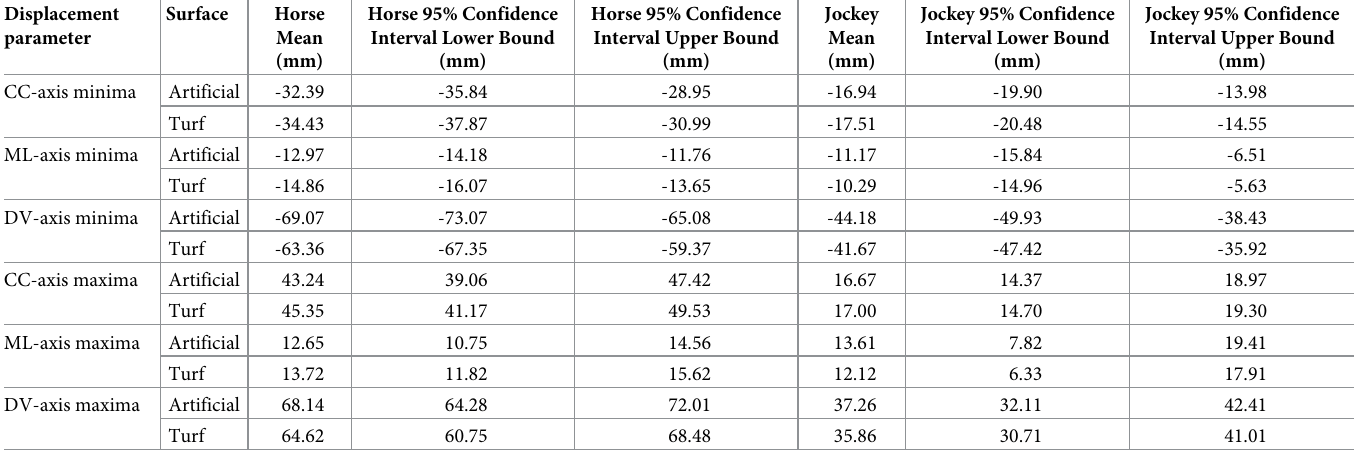
Table 3. Estimated marginal means and confidence intervals for surface effects. Displacement parameter